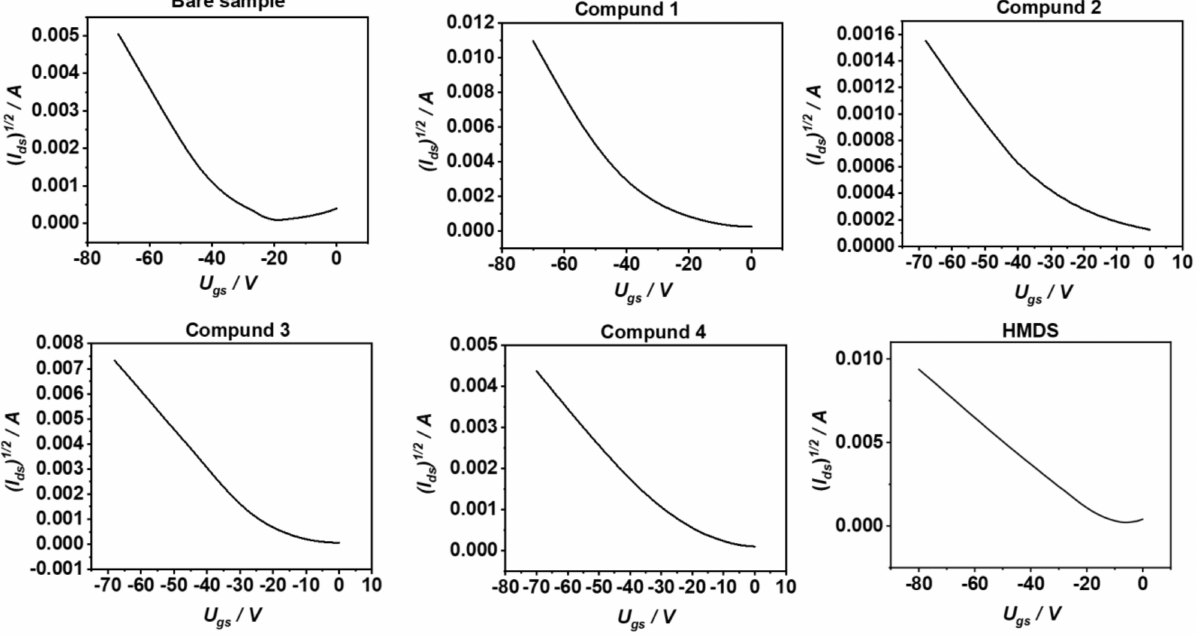
Figure 6. Transfer characteristics for transistors without a zwitterionic interlayer, with interlayers of BQMIs 1–4 , and with an HMDS